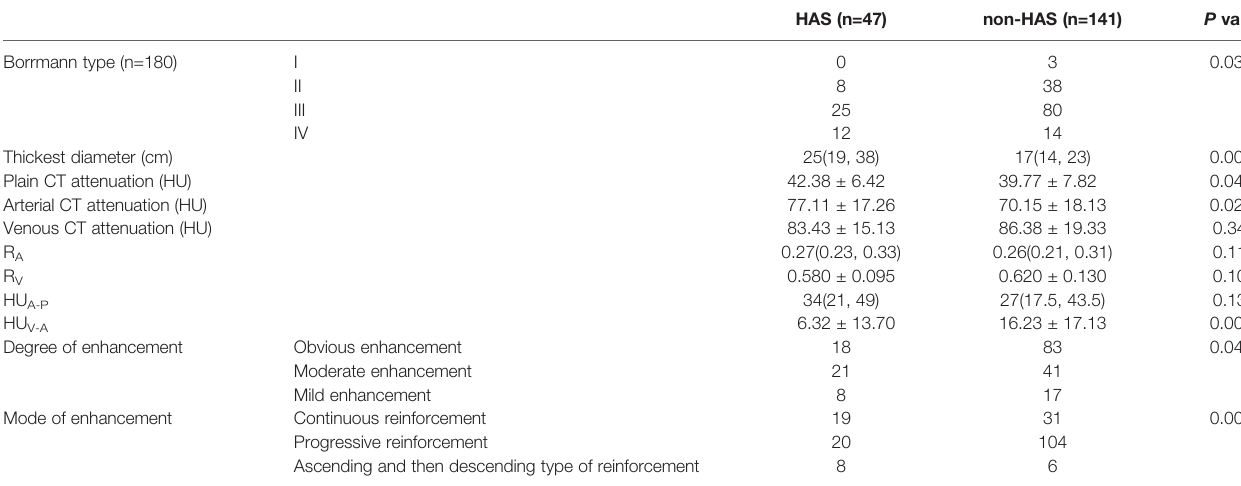
TABLE 2 | Comparison of CT features between HAS and non-HAS